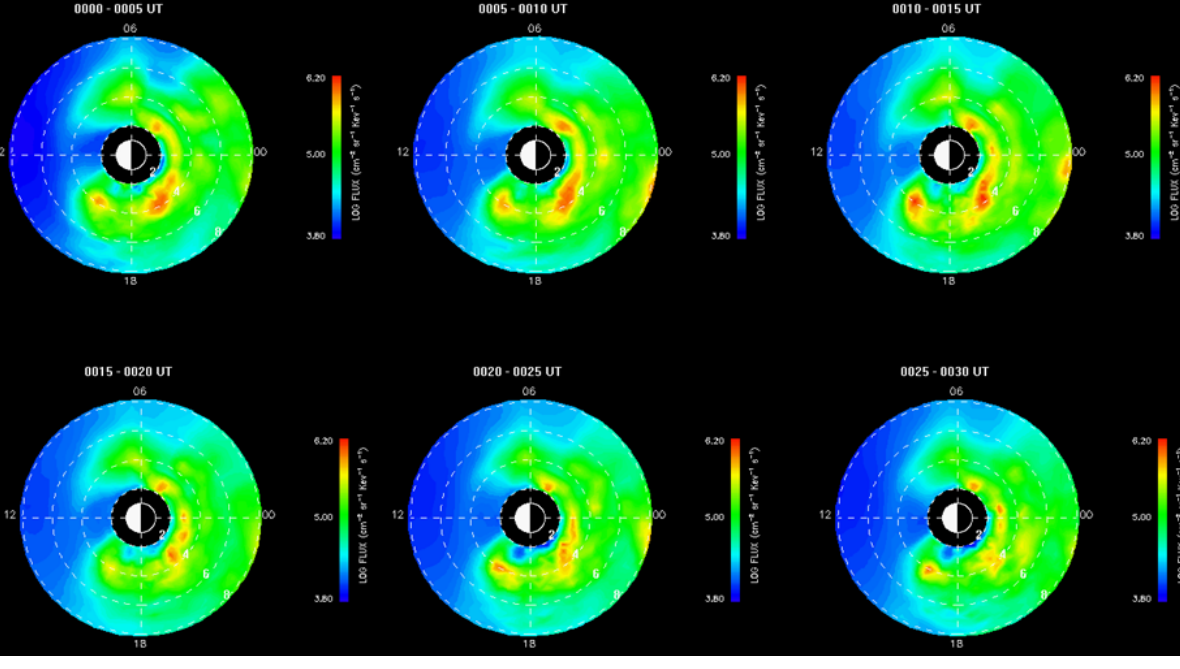
Fig. 14. Retrieved ion-fluxes for five-minute integration measurements displayed in the same format employed in Fig. 7. The epochs are provided at the top of each